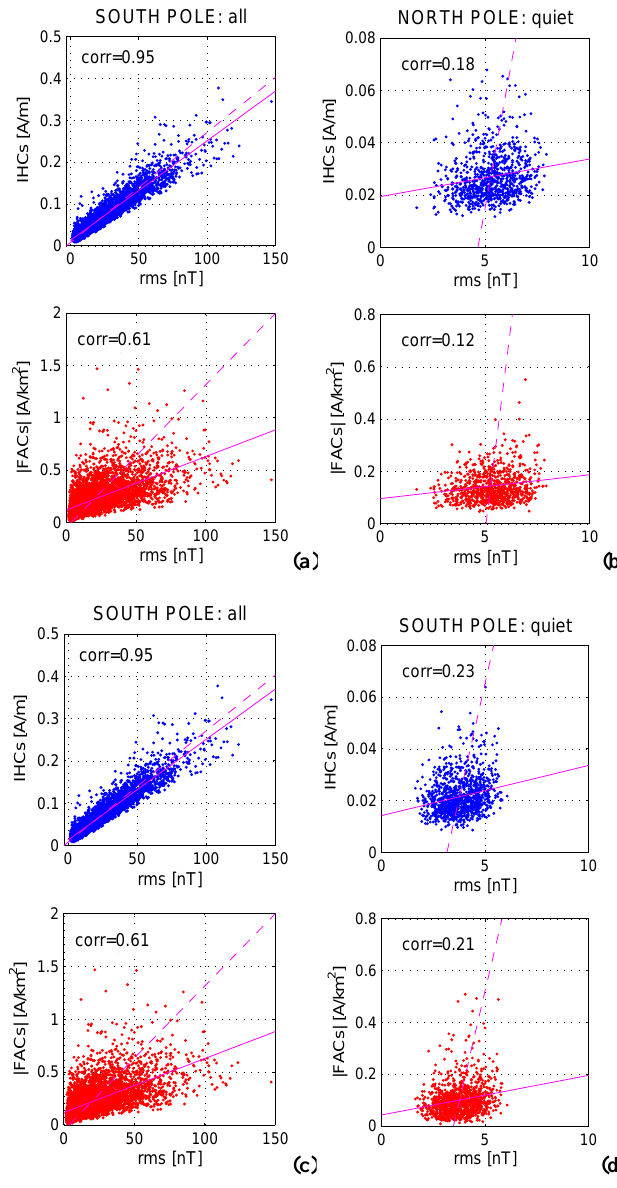
Fig. 3. Correlation analysis between the rms values of the residuals and both the ionospheric Hall and the field-aligned currents deter- mined from CHAMP data at the north (left) and south pole (right). Left columns for “normal” passes, and in the right columns those accepted by the rms criterion for very quiet orbits. The possible range of regression lines is indicated, and the correlation coeffi- cients R (“corr”) are listed in the